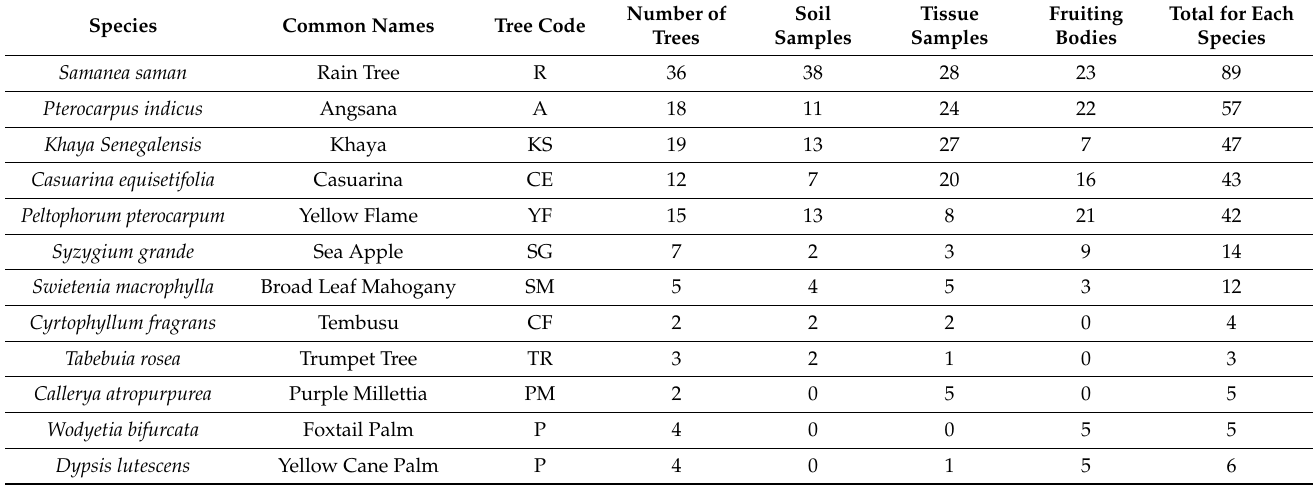
Table 1. Summary tabulation of the soil, tissue and fruiting body samples taken from the respec- tive